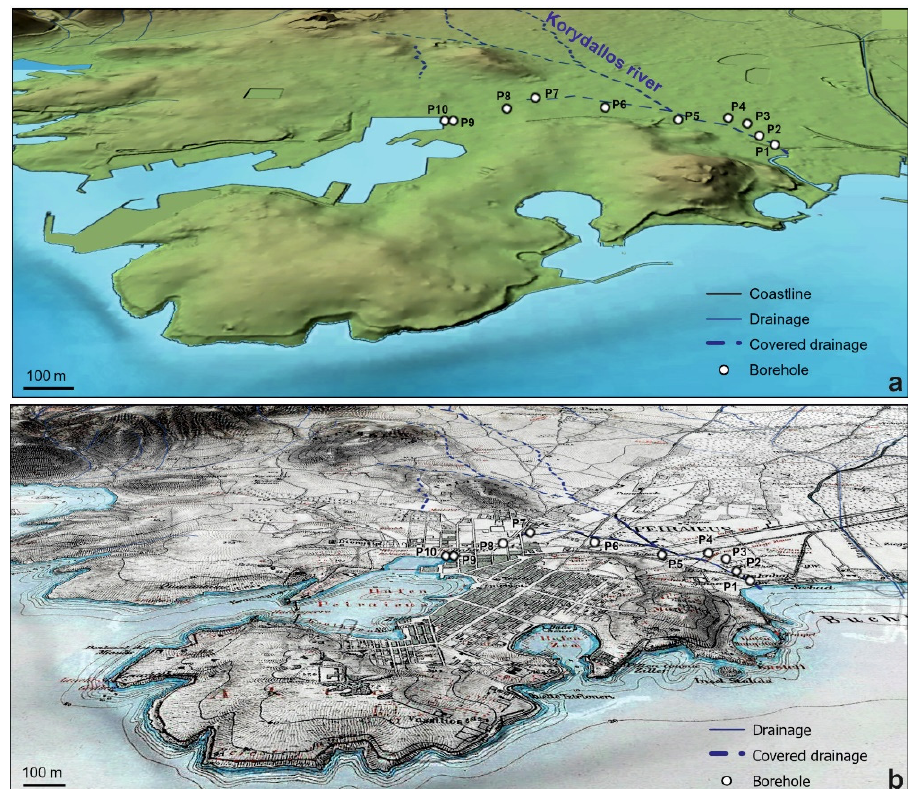
Figure 6. ( a ) The present landscape of Piraeus coastal plain and the location of the drilled boreholes; ( b ) A map of the late 19th century [69], projected on the present landscape, showing the city of Piraeus and the Korydallos River flowing within the Piraeus coastal plain; Korydallos was an active element of the drainage system until the urbanization of the area.